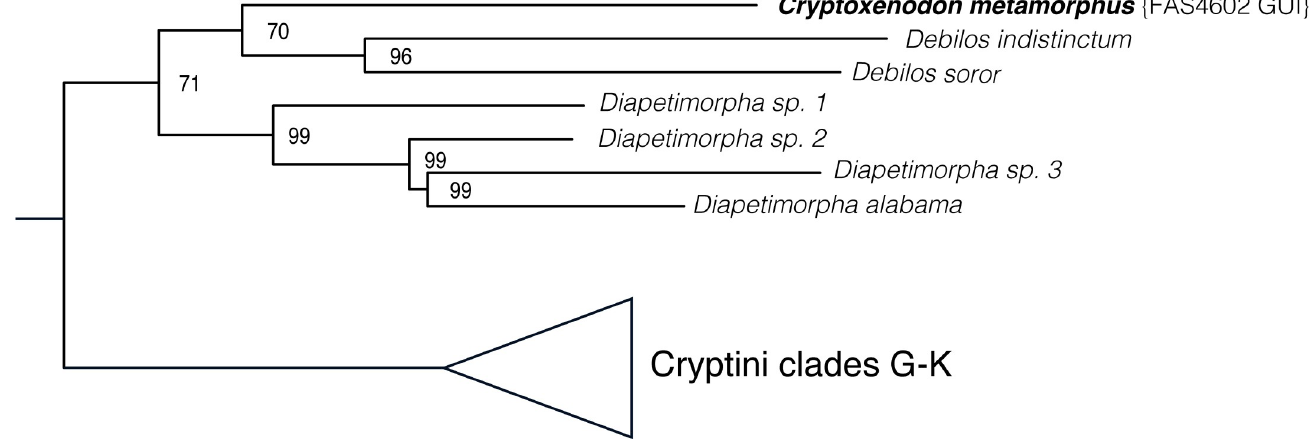
Fig 3. Phylogenetic placement of Cryptoxenodon gen. nov. in the maximum-likelihood tree using the molecular and morphological matrix of Santos [12]. Clade names refer to the major genus-groups identified in this previous work. See S3 File for the complete tree.